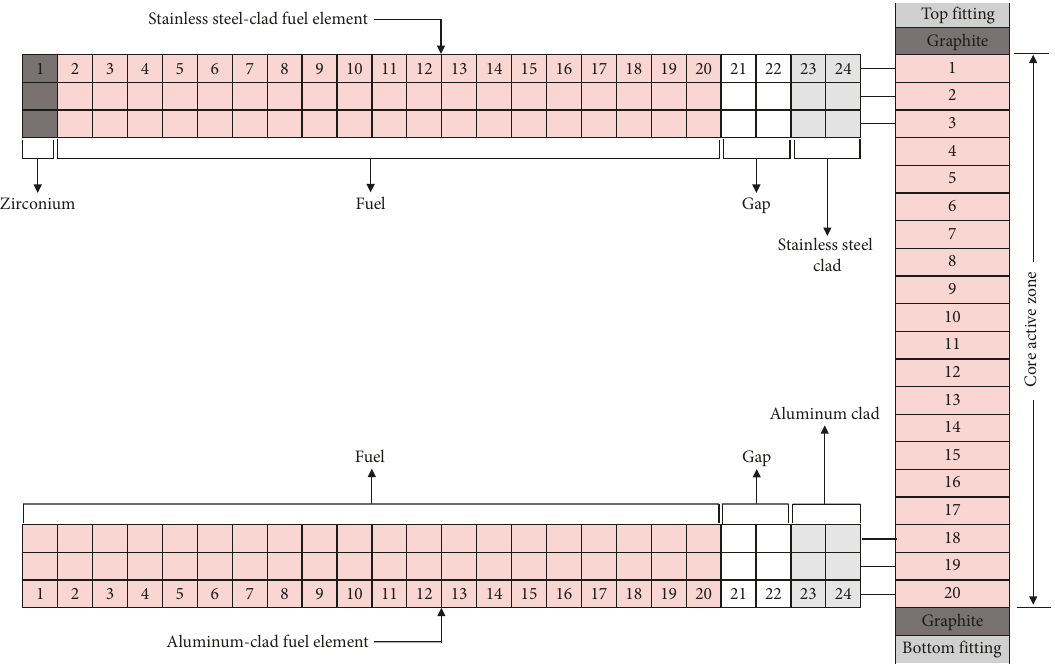
Figure 8: Two-dimensional representation of the heat structure in the RELAP5 model.